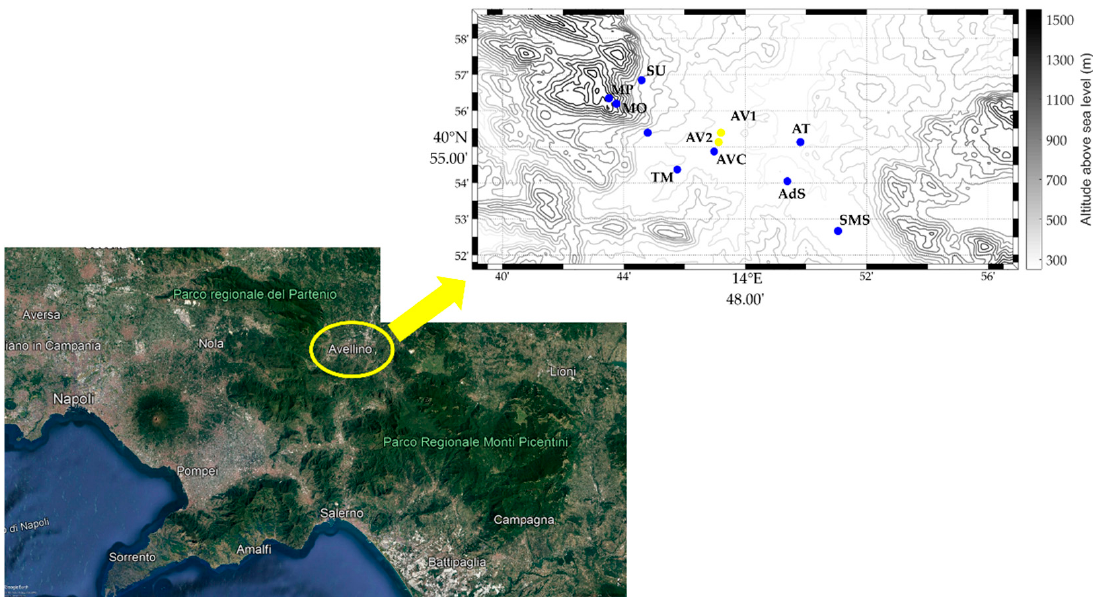
Figure 1. Study area (lower panel) and colocation of ARPAC and AURA monitoring stations (upper panel). The yellow circles indicate the ARPAC stations, whereas the blue circles refer to the AURA network.